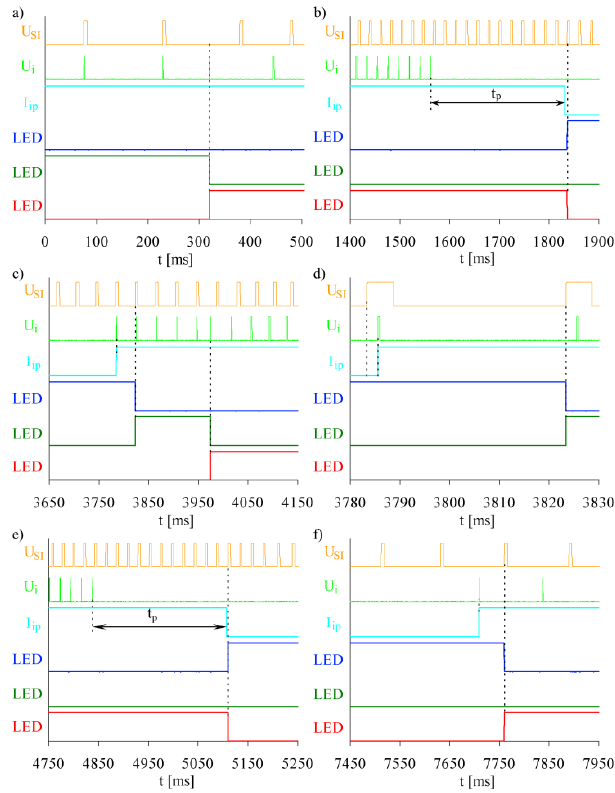
Fig. 9. The results of the test of the indicator of the type of mixture at the characteristic